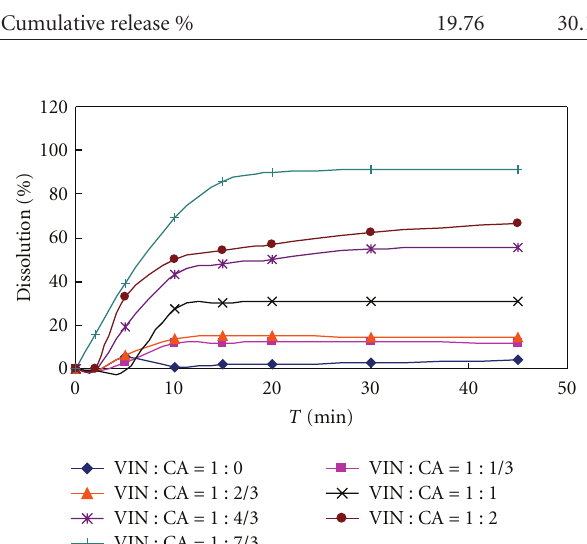
Table 2: Cumulative dissolution of core tablets and release of coating tablets in 0.5% SDS and water. Molar ratios of vin and citric acid